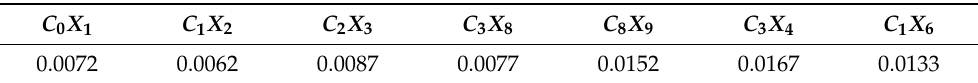
Figure 1. Left panel : Layout connectivity of IBM backend ibmq_boeblingen ; Middle and right panels : Circuits used to generate 6-qubit state ( left ) and 8-qubit GHZ state ( right ). qbit refers to the quantum registers used in qiskit, and q corresponds to qubits on the real device. Table 1. Two qubit error rates for the relevant gates used in generating 6-qubit and 8-qubit GHZ states on ibmq_boeblingen